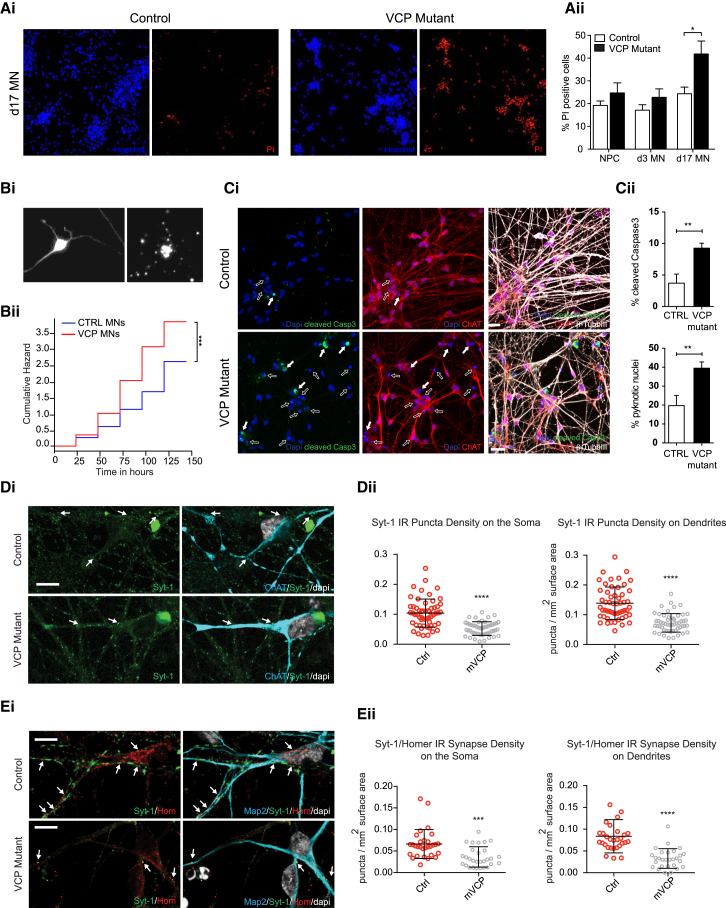
VCP-Mutant Motor Neuron Cell Survival and Synaptic Phenotypes(A) (Ai) Representative images of Hoechst (blue) and propidium iodide (PI; red) staining in control and VCP-mutant d17 MNs. (Aii) Quantification of percentage of PI-positive cells in control and VCP-mutant MNs; n = 3 control lines and 4 mutant lines for NPC, d3 MN and d17 MN; p < 0.05, unpaired t test; % cell death for each line at each time was calculated from at least two independent inductions per line on separate days and with at least three replicate wells per induction per day. At least 2,000 cells were counted for each well. Data represent mean ± SEM.(B) Longitudinal imaging based survival analysis comparing VCP-mutant versus CTRL MNs. (Bi) Representative images showing a MN captured by longitudinal imaging when alive (left panel) and dead (right panel).(Bii) VCP-mutant MNs present increased cumulative risk of death under basal conditions (cumulative hazard ratio [cHR] = 1.75, p = 1.08 × 10−8; CTRL MNs taken as baseline). N = 3 control lines and 3 VCP-mutant lines. To estimate survival Kaplan–Meier and cumulative risk-of-death curves were plotted using R, while Cox proportional hazards analysis, also calculated in R, was used to determine the influence of the VCP mutation on survival of MNs. The survival plot is presented with time in hours on the horizontal axis and the cumulative risk expressed as a logarithm on the vertical axis. The cumulative hazard ratio value is presented in non-logarithmic form, and is based on the control MNs, posed as 1.(C) (Ci) Representative confocal images showing apoptotic (full arrows) and pyknotic (empty arrows) cells at d17 of terminal differentiation. Scale bar: 25 μm. (Cii) Proportion of cells positive for cleaved caspase 3 (top) or with nuclear pyknosis (bottom) over total number of cells. Data are expressed as mean ± SD, ∗∗p < 0.01; unpaired t test.(D) Analysis of synaptic puncta in hiPSC-MNs with or without VCP mutations. (Di) Images of single planes taken by confocal microscopy, showing presynaptic synaptic marker SYT-1 (green) adjacent to the membrane of MNs (ChAT in blue) with intact nuclei (DAPI is white). (Dii) Graphs represent mean synapse density values defined by puncta per surface area on the MN soma and dendrites (N = 51-56 cells or dendrites).(E) (Ei) Images of a single confocal plane, demonstrating pre- and post-synaptic puncta labeled by SYT-1 and Homer-1 immunofluorescence, respectively. (Eii) Graphs demonstrating synaptic densities defined by proximity analysis of SYT-1 and Homer-1 positive puncta and expressed as mean number of closely adjacent puncta/cell surface area on the soma or dendrites (N = 28-30 cells or dendrites). Data represent mean ± SD. Taken together, the synaptic data in this figure were generated from 3 control lines and 3 mutant-VCP lines, each of which was technically triplicated. ∗∗∗p < 0.001, ∗∗∗∗p < 0.0001, unpaired t test. Scale Bar: 25 μm. NPC = neural precursor cells, MNs = motor neurons, d3 or d17 = after 3 or 17 days of terminal differentiation.